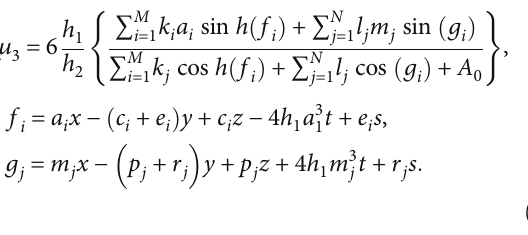
Figure 3: The parameters of μ e 2 = m 1 = m 2 = 3, A 0 = z = t = s = 0 . (a) Three-dimensional map. (b) Contour